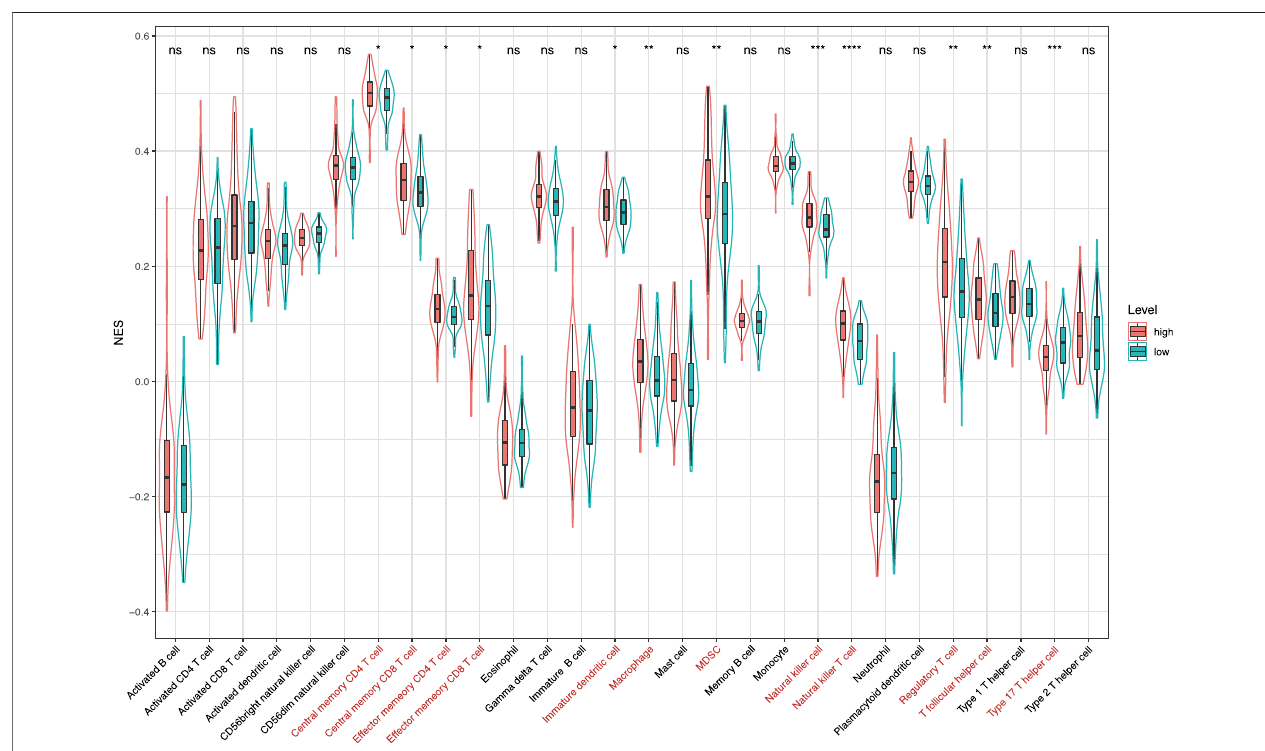
FIGURE10| Normalizedenrichmentscoresof28kindsofimmunecellsinthehigh-riskandlow-riskgroups.* p < 0.05;** p < 0.01;*** p < 0.001;and**** p < 0.0001; ns, not signi fi cant.